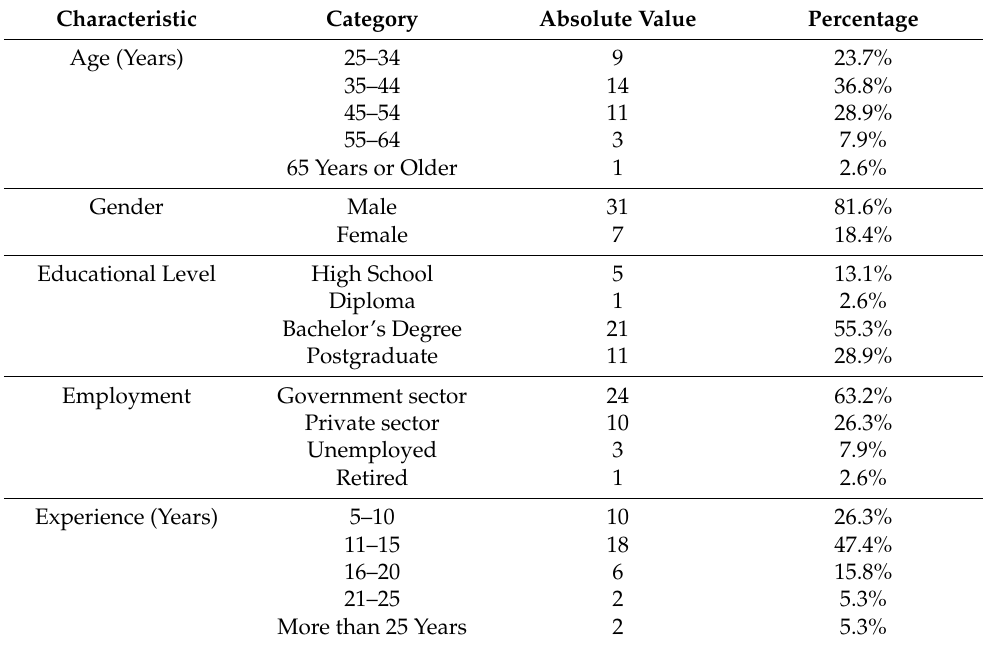
Table 1. Demographic Details of the